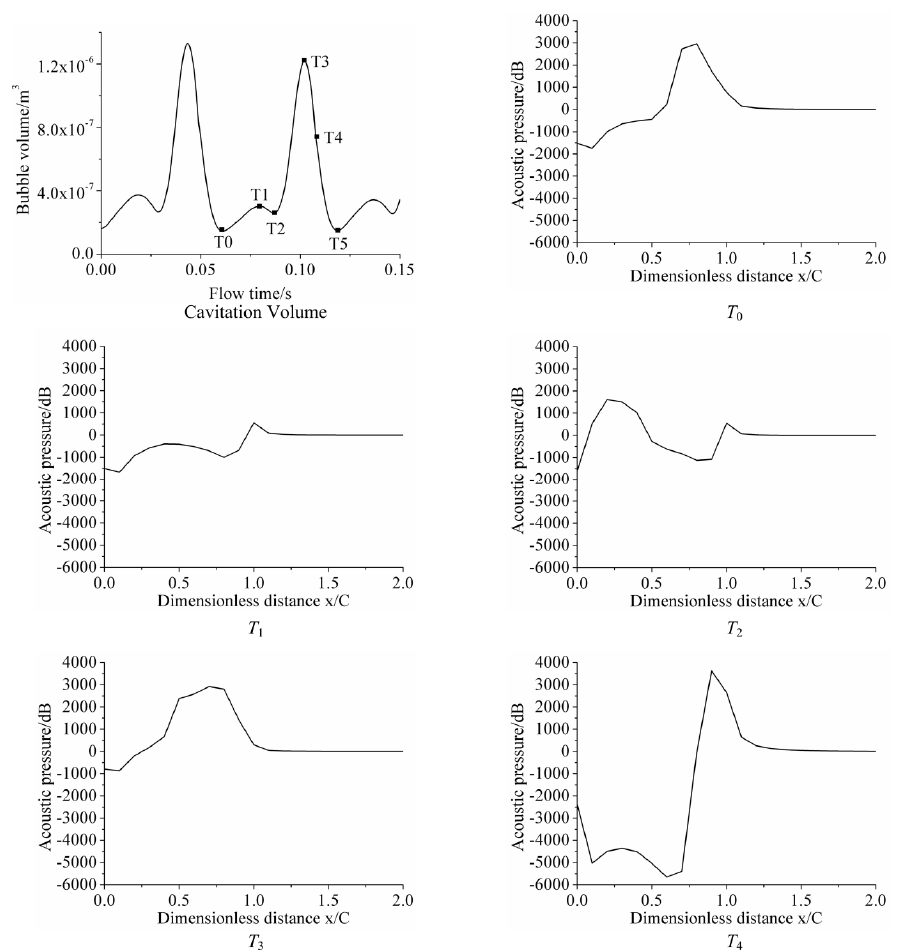
Figure 14. Acoustic pressure at different flow times for σ = 0.65.